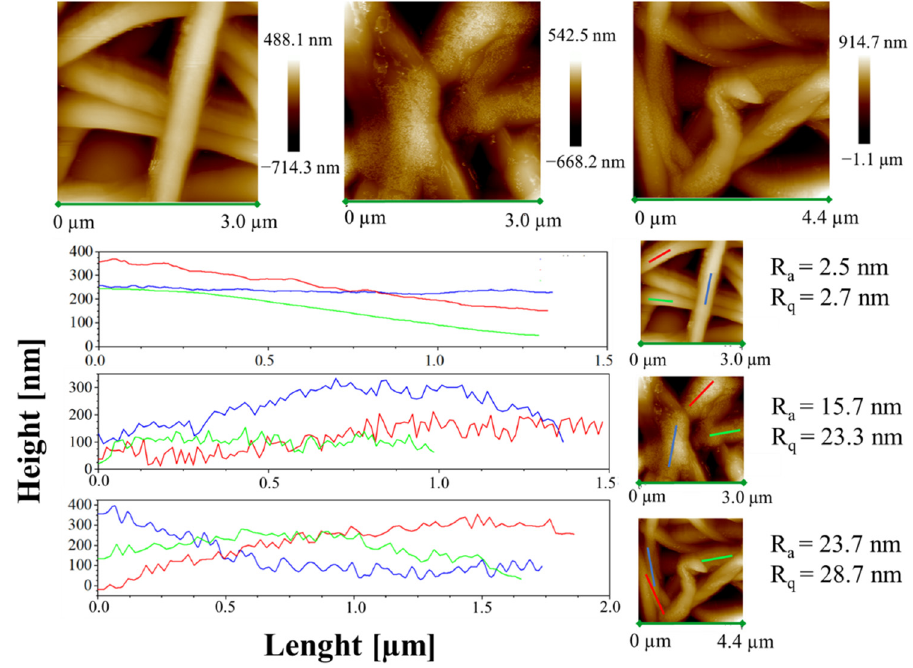
Figure 11. Height AFM images and profiles of the height variations along the lines parallel to the axis fibers for the samples PCL, 1%AuM1 and 3%AuM1.